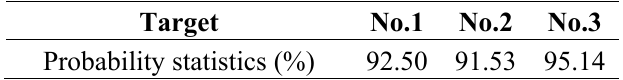
Table 4. Correct track probabilities (200 runs,